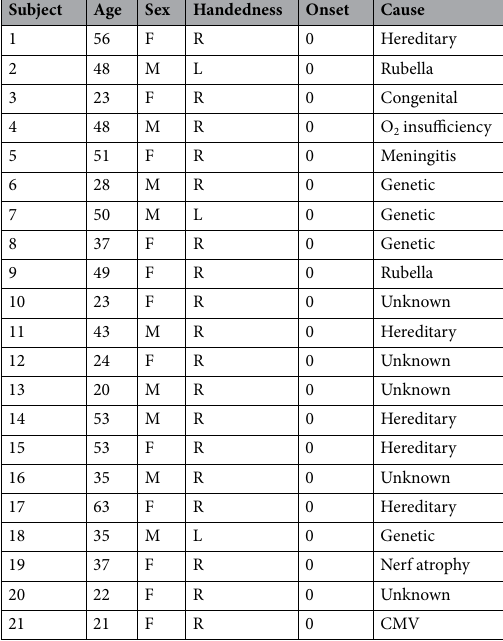
Table 1. Characteristics of deaf participants. R, right-handed; L, left-handed; F, female; M, male; CMV,